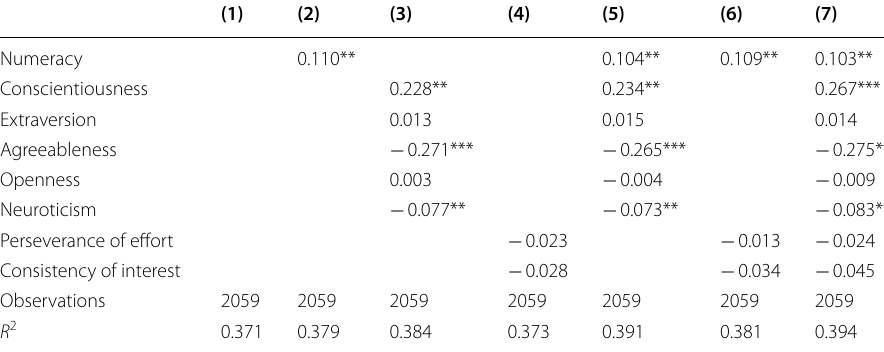
Table 4 Wages and cognitive and non-cognitive